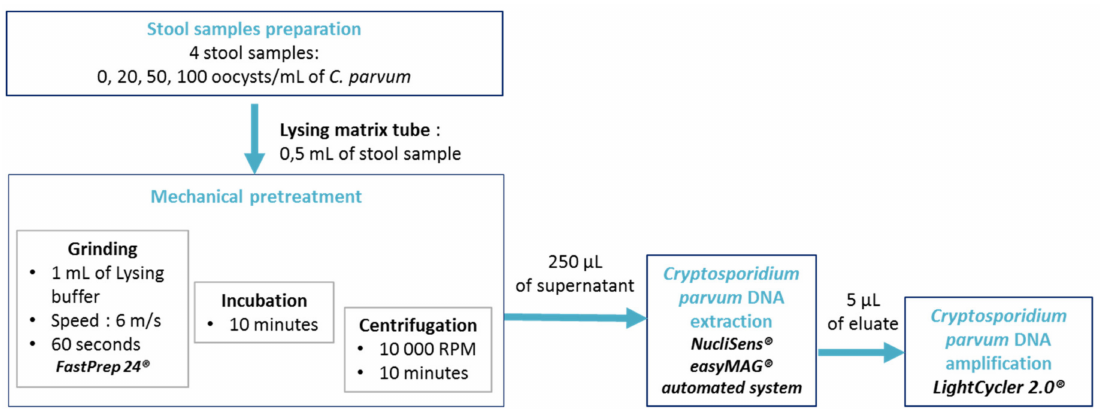
Figure 1. Experimental protocol flow chart (RPM: revolution per minute).